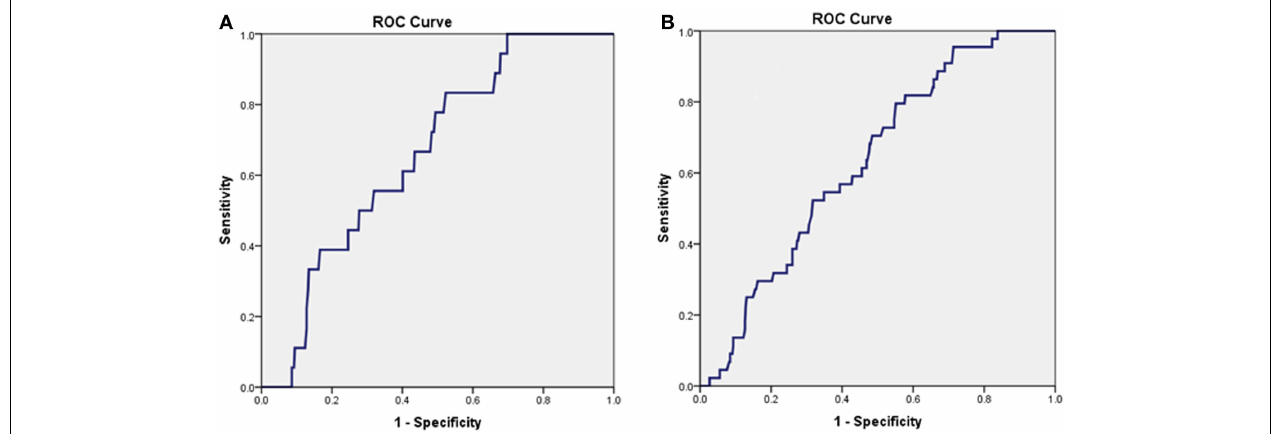
FIGURE 3 | Presentation CNPsp levels lower than 52ng/L could generate significant AUC curves for the identification of death within 1year ( n = 18, AUC = 0.663, P = 0.019) (A) and the composite end-point of death/MI within 1 year ( n = 44, AUC = 0.631, P < 0.01) (B)